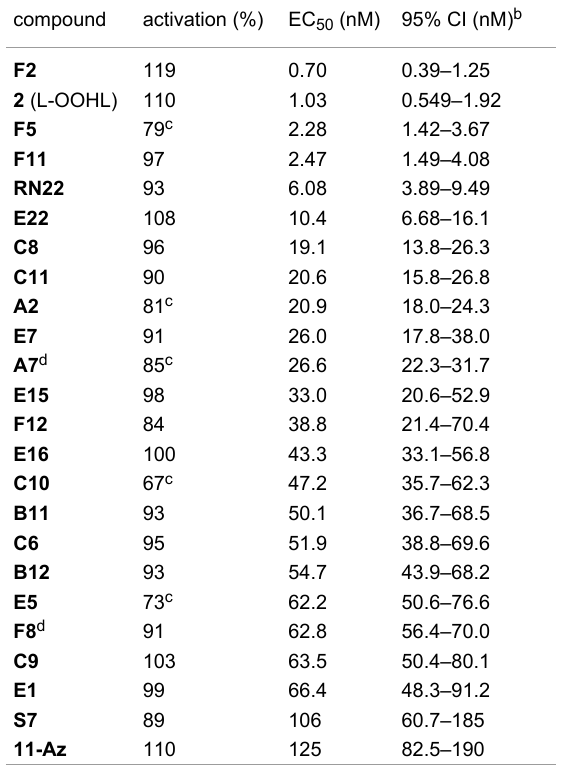
Table 1: Characterization data for SdiA agonists (listed by potency). a